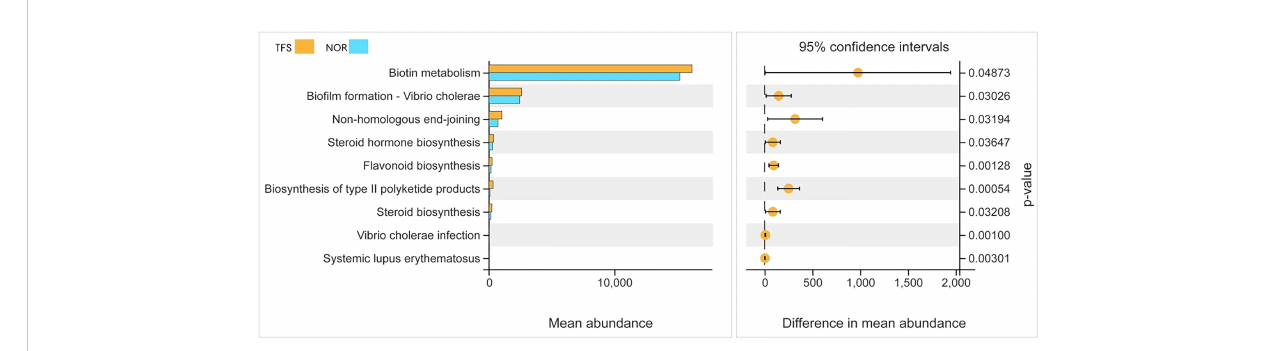
FIGURE 7 Functional differences in intestinal microbial communities between normal (NOR) and TFS D. hystrix . Functions were predicted by PICRUSt2 analysis of bacterial sequences. Signi fi cantly different functions (P < 0.05) of KEGG pathway categories (level 3) are